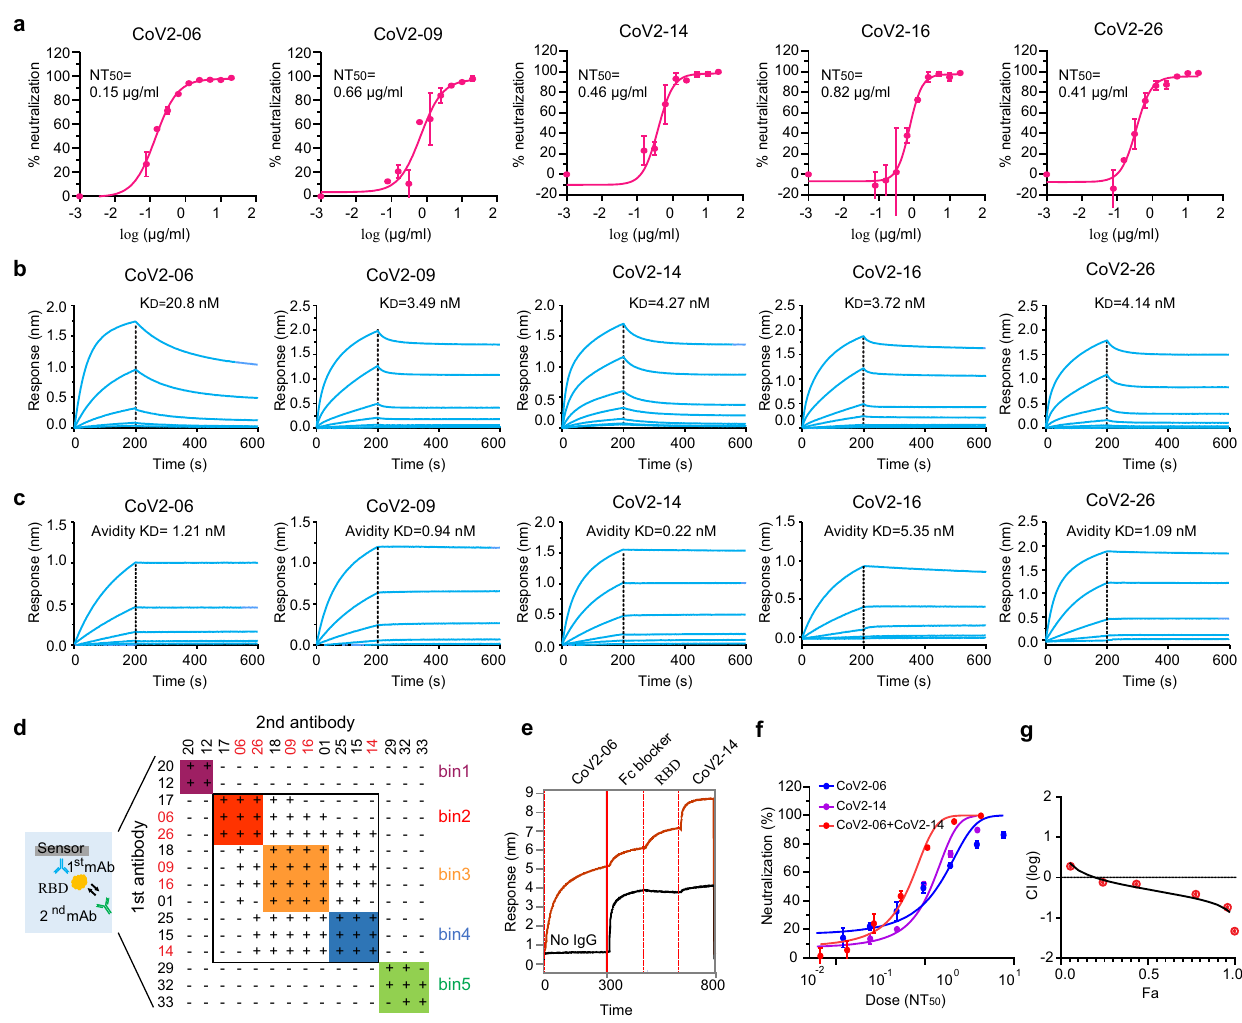
Fig. 2 Identi fi cation of CoV2-06 and CoV2-14 as two neutralizing mAbs suitable for cocktail. a Neutralization titration curves of the top fi ve mAbs with 50% neutralization titer (NT 50 ) below 1 µ g/ml. Each data point is the mean ± SD of two replicates. b , c Kinetic binding curves of the top fi ve mAbs to the RBD protein ( b ) and the prefusion S protein ( c ) of SARS-CoV-2. The vertical dashed lines indicate the separation of association and dissociation phases. d Epitope binning of 15 mAbs by a BLI-based cross-competition assay. Antibodies grouped into different bins shown in different colors. The top fi ve neutralizing mAbs are shown in red; “ + ” denotes that the fi rst antibody competes with the second antibody and “ − ” denotes that the fi rst antibody does not compete with the second antibody. e Simultaneous binding of CoV2-06 and CoV2-14 on the sCoV2-RBD protein. f Dose-dependent percent neutralization of SARS-CoV-2 by individual CoV2-06, CoV2-14 mAbs, and a cocktail of the two mAbs; n = 3 biologically independent cells. g Plot of calculated log-scale CI values ( y -axis) versus fractional effects ( x -axis). CI value = 1 indicates additive effect, <1 means synergism, and >1 indicates antagonism. Error bars indicate SD of